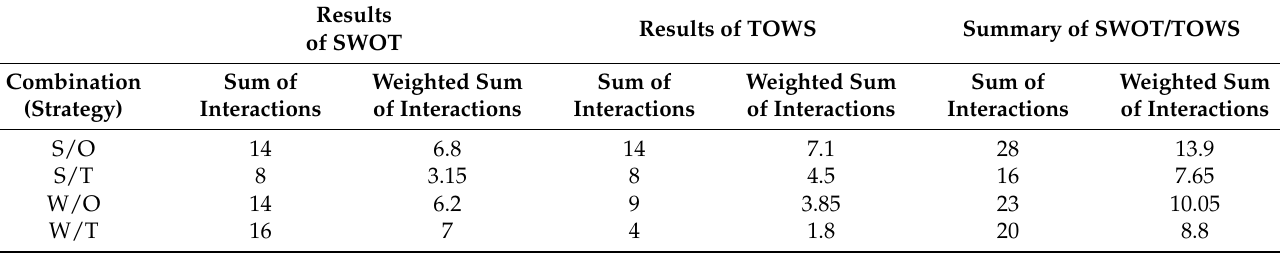
Table A3. Collective results of SWOT/TOWS